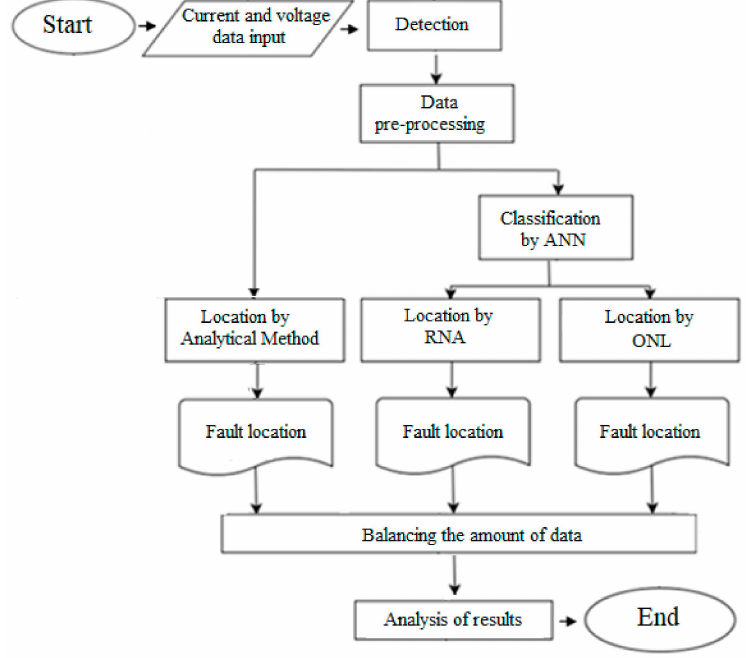
Figure 4. Fault location